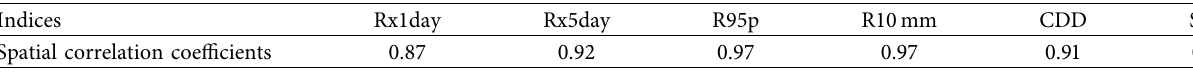
Table 2: Spatial correlation coefficients of the six average annual EPIs for 1986–2005 between model simulation and observation. Indices Rx1day